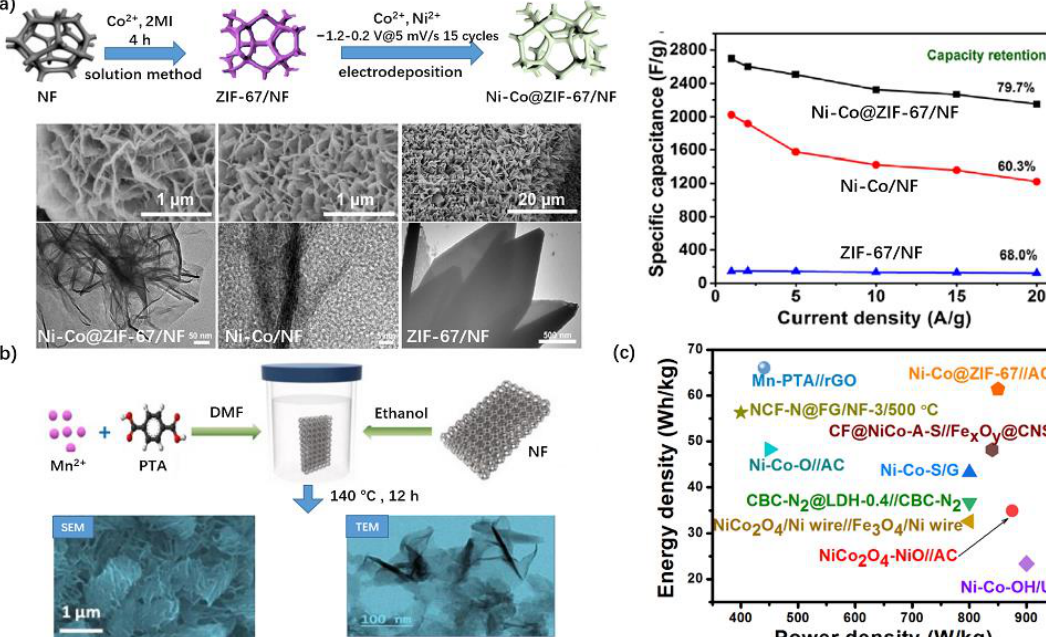
Figure 2. ( a ) Preparations scheme, morphology and electrical performance of Ni-Co@ZIF-67/NF